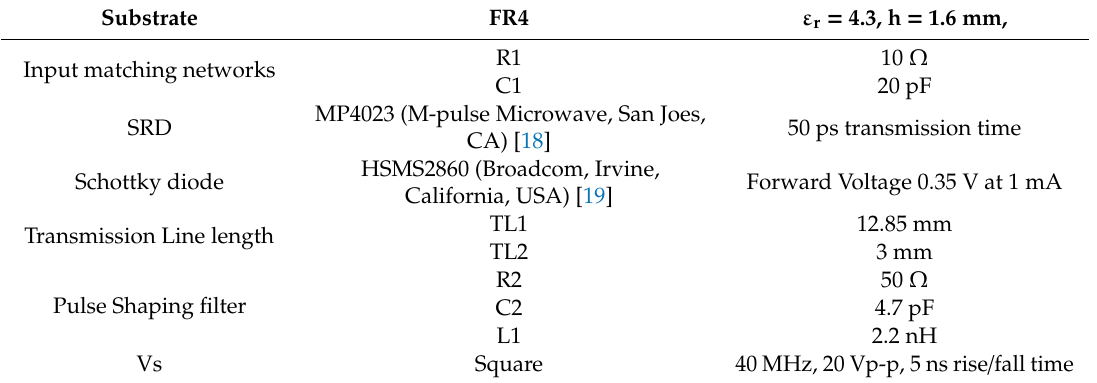
Table 1. Circuit implementation information.